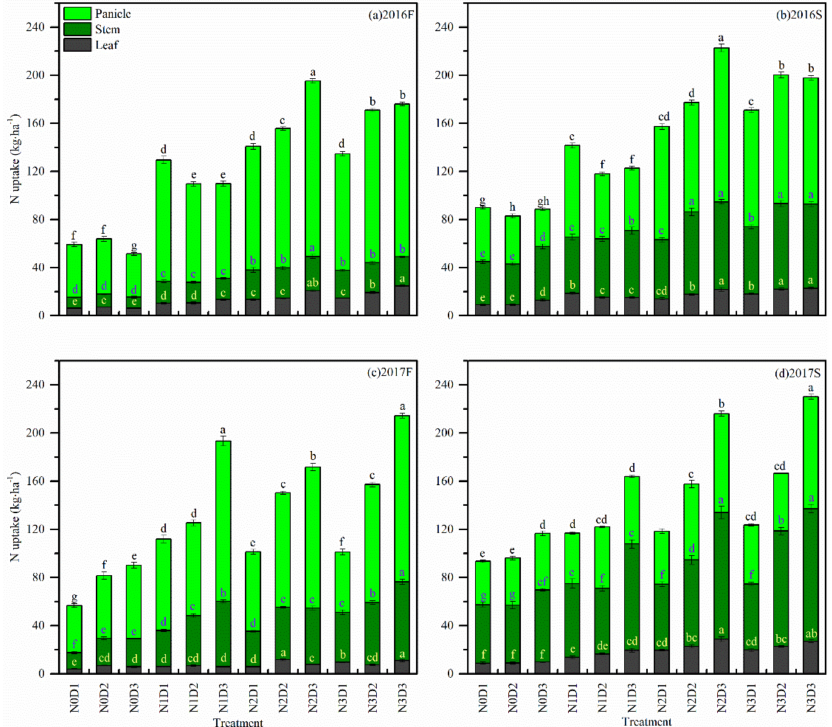
Figure 4. N uptake of aboveground dry matter. ( a ) N uptake in 2016F. ( b ) N uptake in 2016S. ( c ) N uptake in 2017F. ( d ) N uptake in 2017S. Plant N uptake, including the N uptake of stem, leaf, and grain. 2016F, the first season of 2016 (transplanting season). 2016S, the second season of 2016 (regrowth season). 2017F, the first season of 2017 (regrowth season). 2017S, the second season of 2017 (regrowth season). Bars with different letters represent a significant difference at p < 0.05. The yellow letter represents a difference in the leaf. The purple letter represents the difference in the stem. The dark letter represents the difference in the panicle.